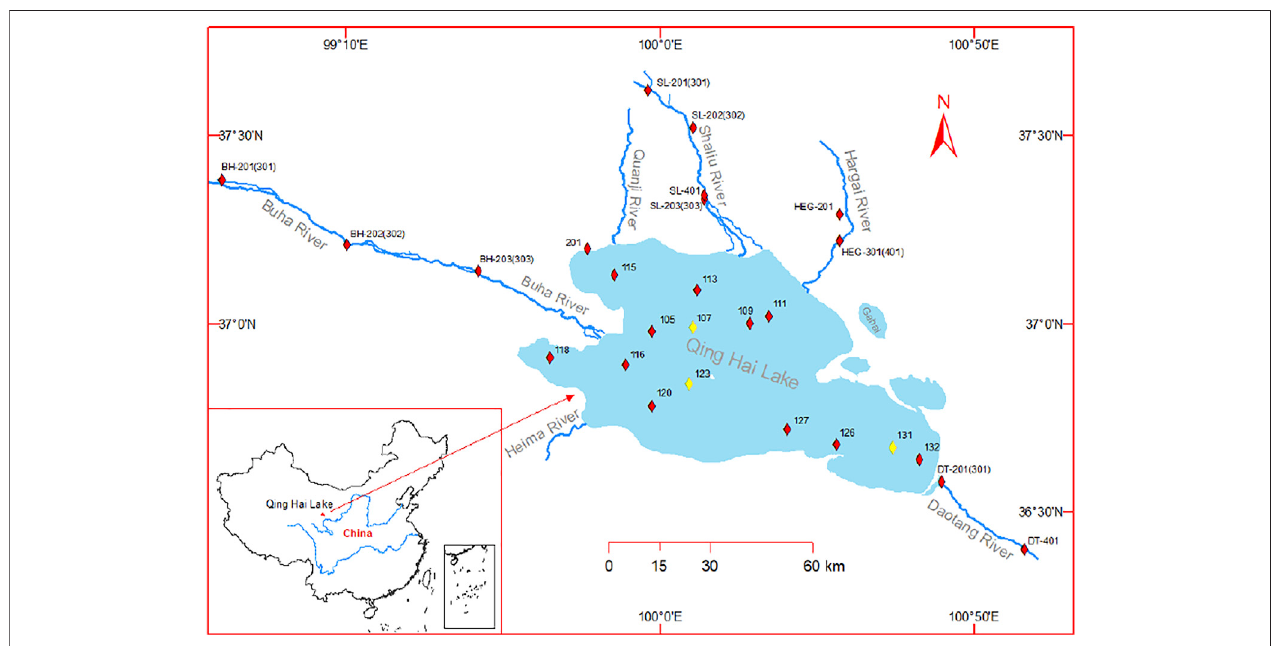
FIGURE 1 | Map showing the locations of the sampled lakes and rivers in the Qinghai region. (Red diamonds represent surface sites and yellow diamonds represent depth pro fi les).